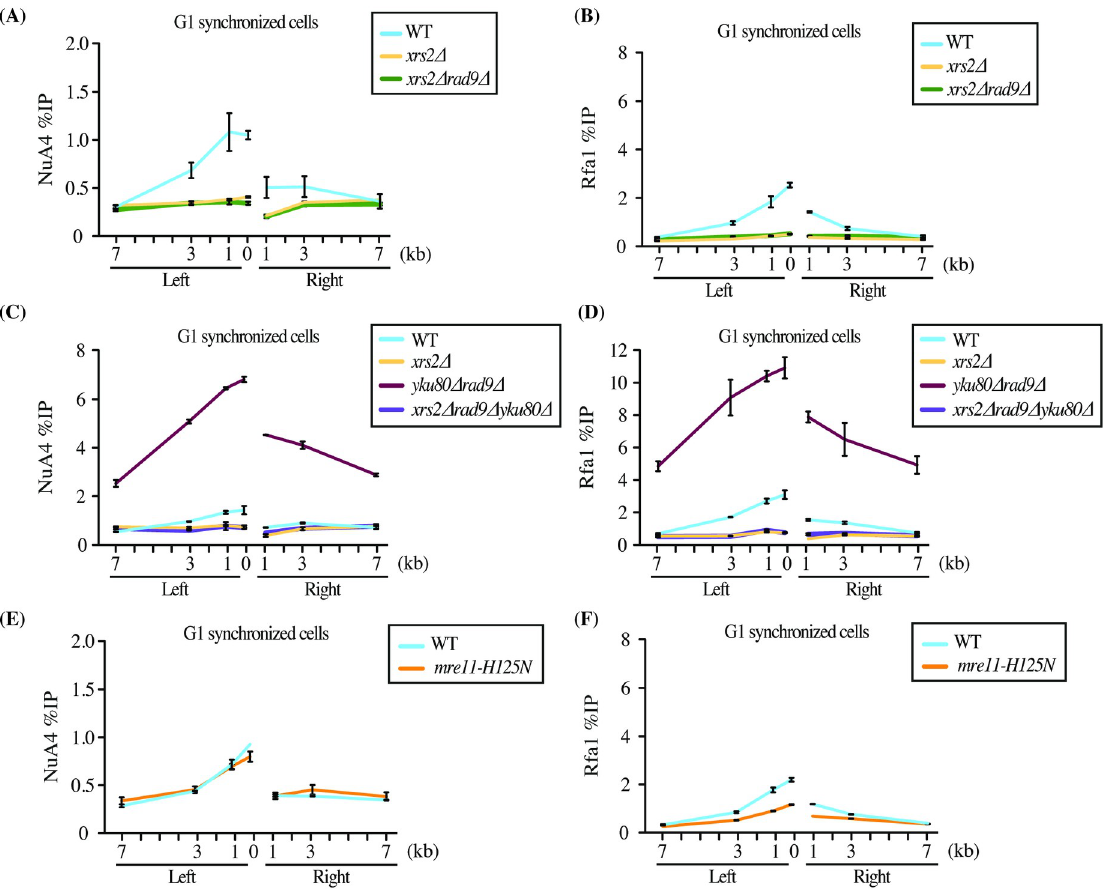
Fig 2. Xrs2-dependent recruitment of NuA4 at a DSB in G1. (A-D) ChIP-qPCR of Rfa1 and Eaf1 shows loss of NuA4 (A, C) and resection (B, D) in xrs2 Δ , xrs2 Δ rad9 Δ and xrs2 Δ rad9 Δ y ku80 Δ compared to wild type at HO-induced DSB in G1 synchronized cells. See also S2D Fig for direct measurement of DNA end resection by qPCR. (E-F) ChIP-qPCR in the mre11-H125N mutant strain shows decreased resection but unaffected NuA4 recruitment compared to wild type in G1 cells. ChIP-qPCR was performed as described in (Fig 1). Yeast strains used showed similar HO cutting efficiency (S2A–S2C